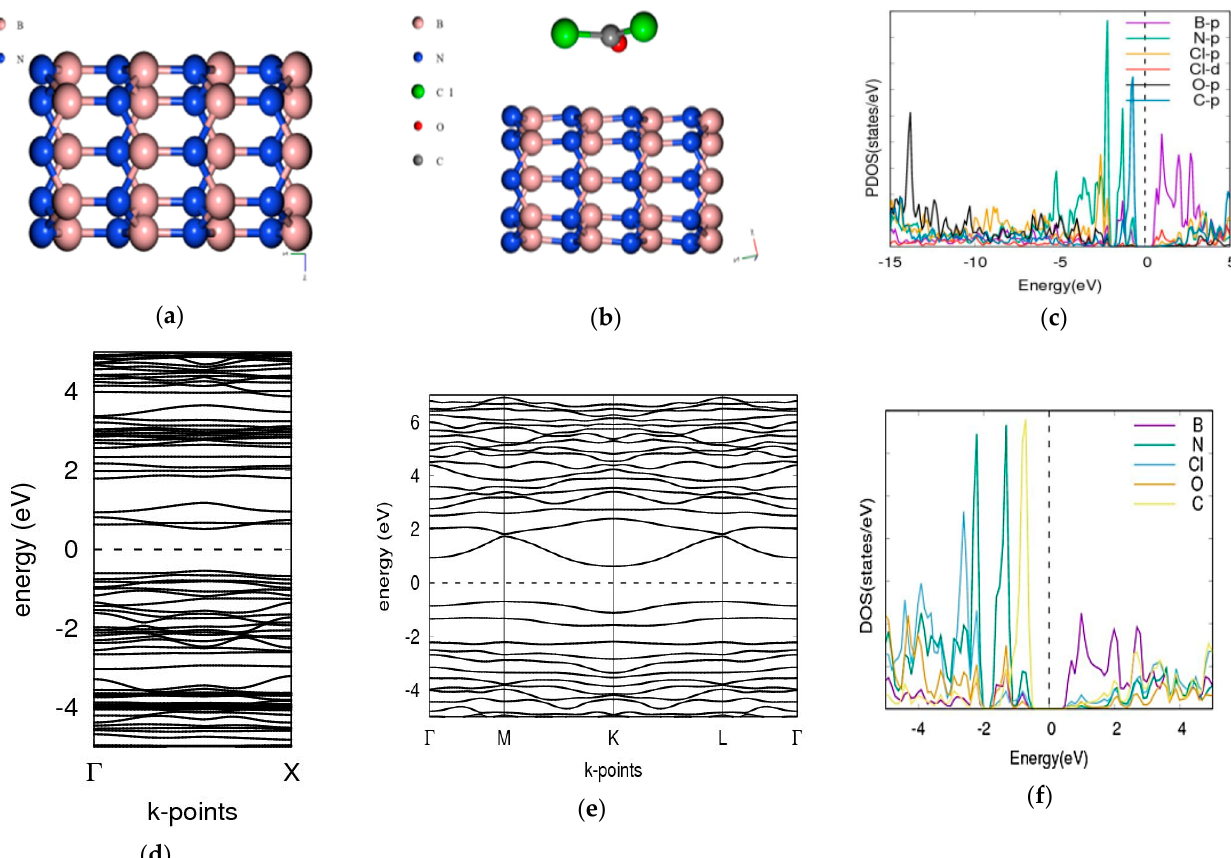
Figure 2. Band structure and density of states for BNNT and phosgene gas interaction. ( a ) [5,0] Boron nitride nanotube (BNNT), ( b ) phosgene-BNNT, ( c ) phosgene-[5,0] BNNT PDOS, ( d ) BNNT band structure Eg = 3.4181 eV, ( e ) phosgene-BNNT Eg = 4.3627 eV, ( f ) phosgene-BNNT DOS.